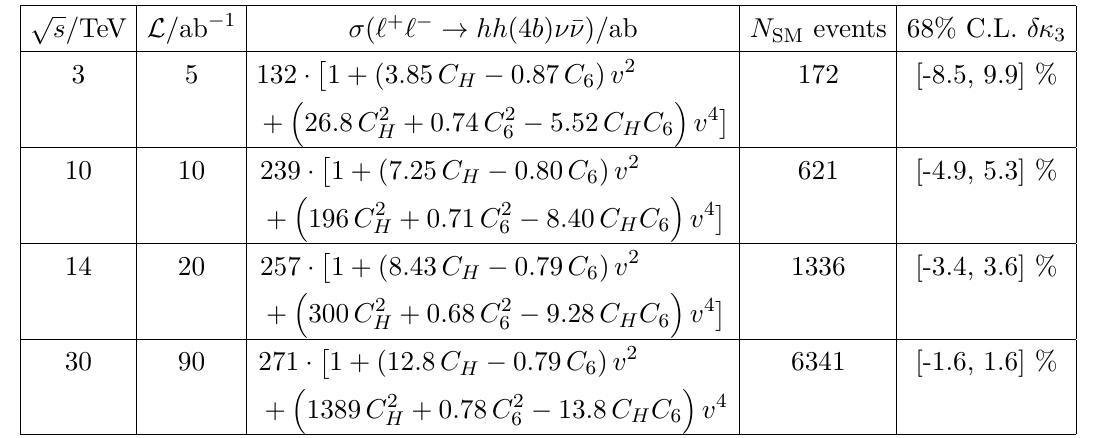
Table 7 . Fiducial σ ( ‘ + ‘ − → hh (4 b ) νν ) in ab at various high energy lepton colliders as a function of the new physics couplings C H and C 6 , normalized with v = 246 GeV. The cross-sections are calculated in the fiducial region 10 ◦ < θ b < 170 ◦ , p T,b > 10 GeV. We also report the number of SM events, and the corresponding 68% C.L. bound on the modified trilinear coupling δκ 3 , calculated neglecting backgrounds and assuming a selection efficiency (cid:15) sig = 26% on the